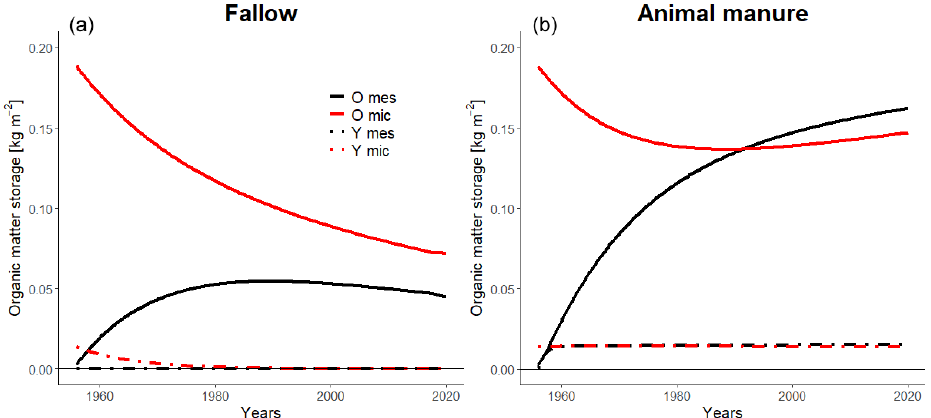
Figure 10. Simulated temporal development of young undecomposed (Y) and older microbially processed (O) organic matter (kgm − 2 ) stored in meso- and microporous regions in the bare fallow (a) and manure (b)